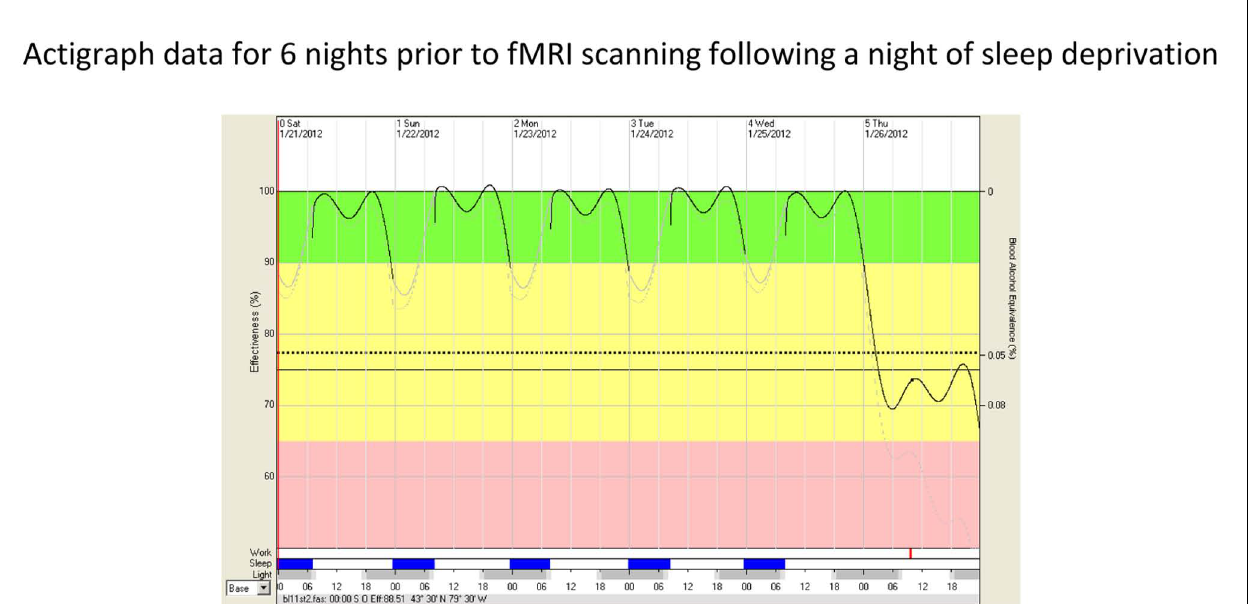
performance effectiveness for workers conducting safety sensitive jobs (e.g., flying, driving, weapons operation, command and control, etc.).The yellow band (from 65 to 90% modeled cognitive effectiveness) indicates caution. Personnel engaged in skilled performance activities such as aviation are recommended not to operate in this bandwidth.The area from the dotted line to the pink area represents the modeled cognitive effectiveness equivalent to the circadian nadir and a second day without sleep.The pink band (below 65%) represents performance effectiveness after two days and one night of sleep deprivation.The abscissa ( x -axis) illustrates a single 15-min period (red bar) during the fMRI scans for each of the baseline and sleep deprivation conditions as well as sleep timing/duration (blue bars), darkness (gray bars), and time of day in hours.The red bar shows a thickening of the modeled cognitive effectiveness line (immediately above the red bar), reflecting cognitive effectiveness during the fMRI